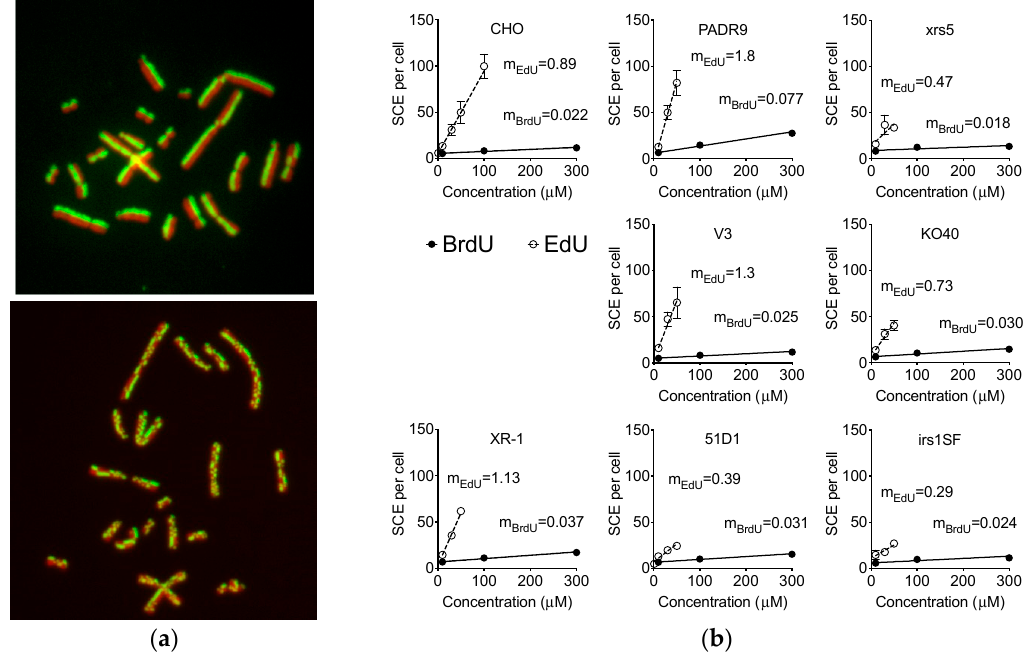
Figure 4. BrdU- and EdU-induced sister chromatid exchange (SCE) formation. ( a ) Representative images of control (upper panel) and 100 μ M of EdU-induced (lower panel) SCE in CHO cells. Green signal indicates EdU and red signal indicates DNA staining with DAPI (pseudo-color); ( b ) SCE formation by BrdU and EdU in DNA repair-deficient cells. Closed circles indicate BrdU treatments and open circles indicate EdU treatments. Error bars represent the standard error of the mean of three independent experiments. m BrdU and m EdU indicate the values of slope in SCE per cell per μ M of BrdU or EdU, respectively.